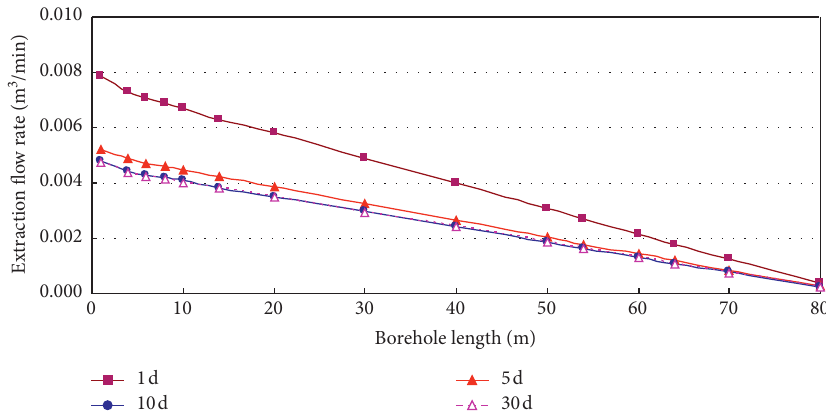
Figure 11: The drainage flow distribution of complete hole along the borehole length.